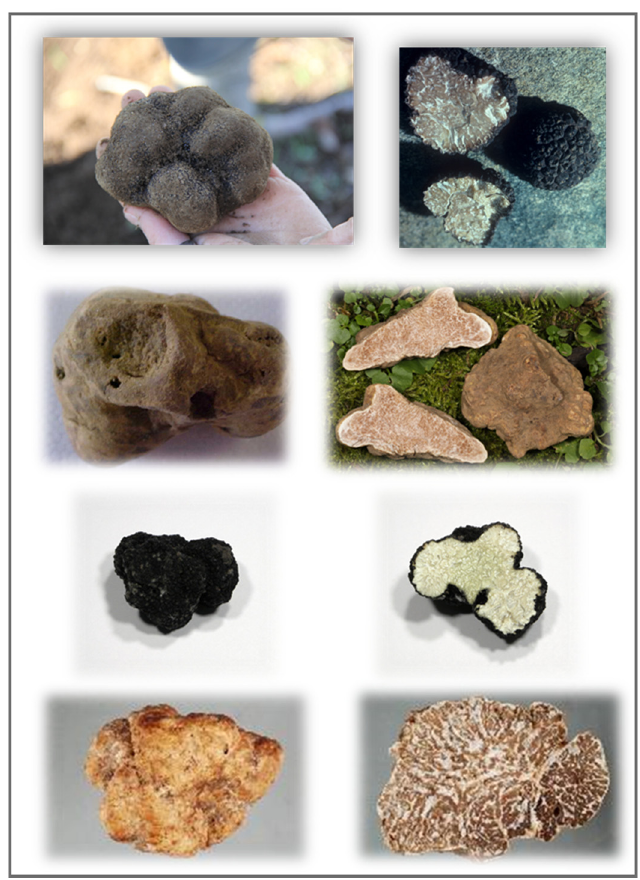
Figure 1. Most valuable truffles occur in Europe such as (from top to bottom) T. melanosporum , T. magnatum , T. aestivum, and T. borchii . (Photos have been provided by “Mycology Collections Portal” https://mycoportal.org/portal/collections/harvestparams.php?db%5B%5D=25&x=46&y=24, accessed